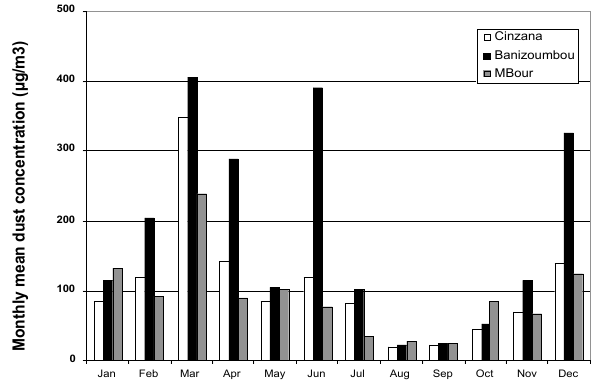
Figure 26. Monthly mean atmospheric concentration of particulate matter lower than 10 µ m (PM10) measured along the Sahelian Dust Transect (M'Bour, Senegal, 14.25°N/16.96°W; Cinzana, Mali, 13.28°N/5.93°W and Banizoumbou, Niger, 13.31°N/2.66°E) in 2006 (see their location on Fig.1). (the monthly means have been computed from the raw daily mean concentrations available on the AMMA data base using on wind direction criterions to select only dust transport wind sectors).